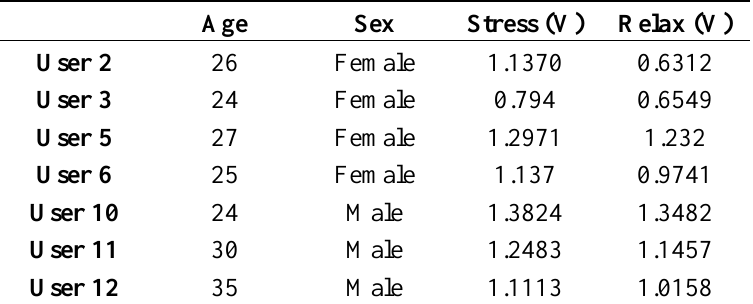
Table 20. Mean values of the SCR from annoying sounds.